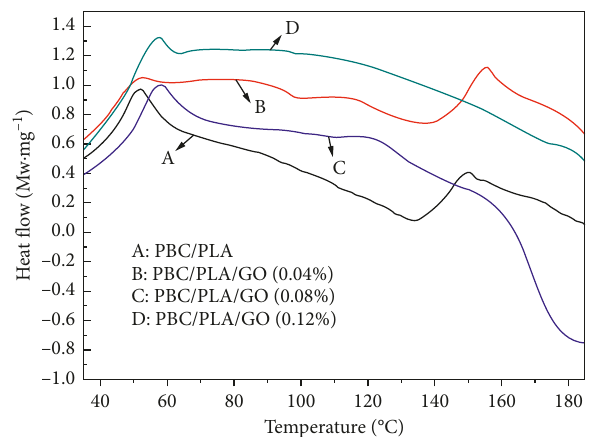
Figure 1: DSC curves of GO/PLA/PBC